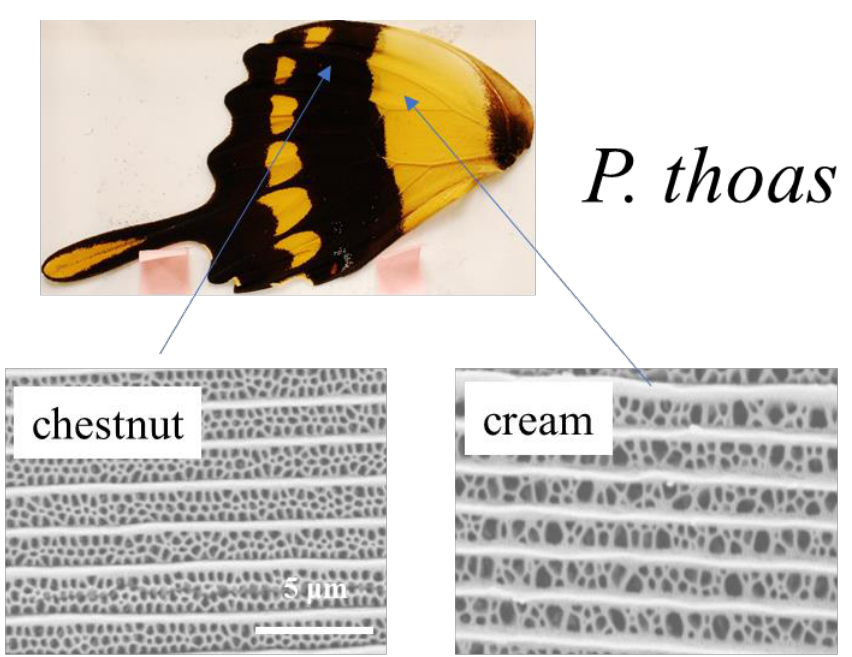
Figure A1. A photograph of a P. thoas wing and SEM images (Hitachi TM3000) showing microstructures of its chestnut and cream scales. Scale bar: 5 µm.